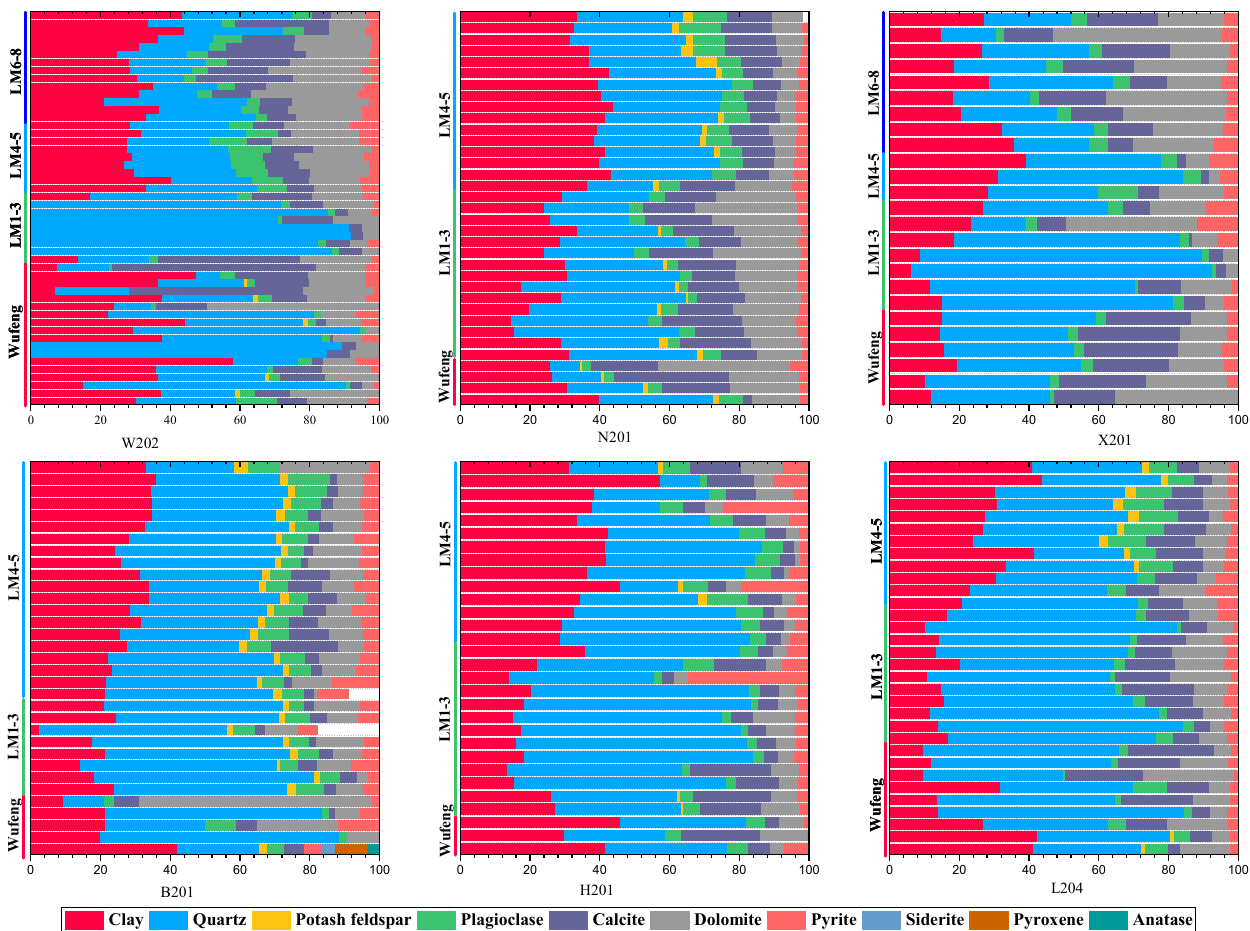
Figure 4. The mineral composition of the shale samples from the six wells.